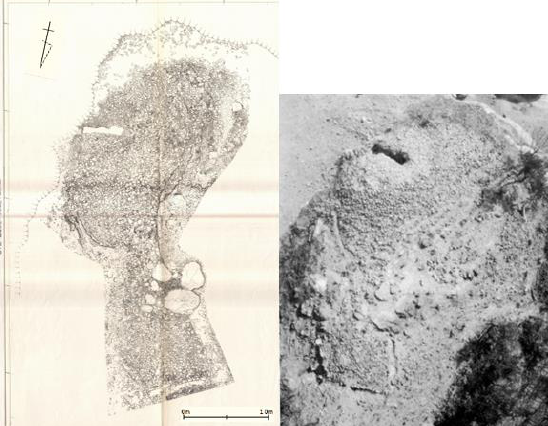
Fig.10 Tsuruo Shrine No. 4 tomb plan and aerial photography